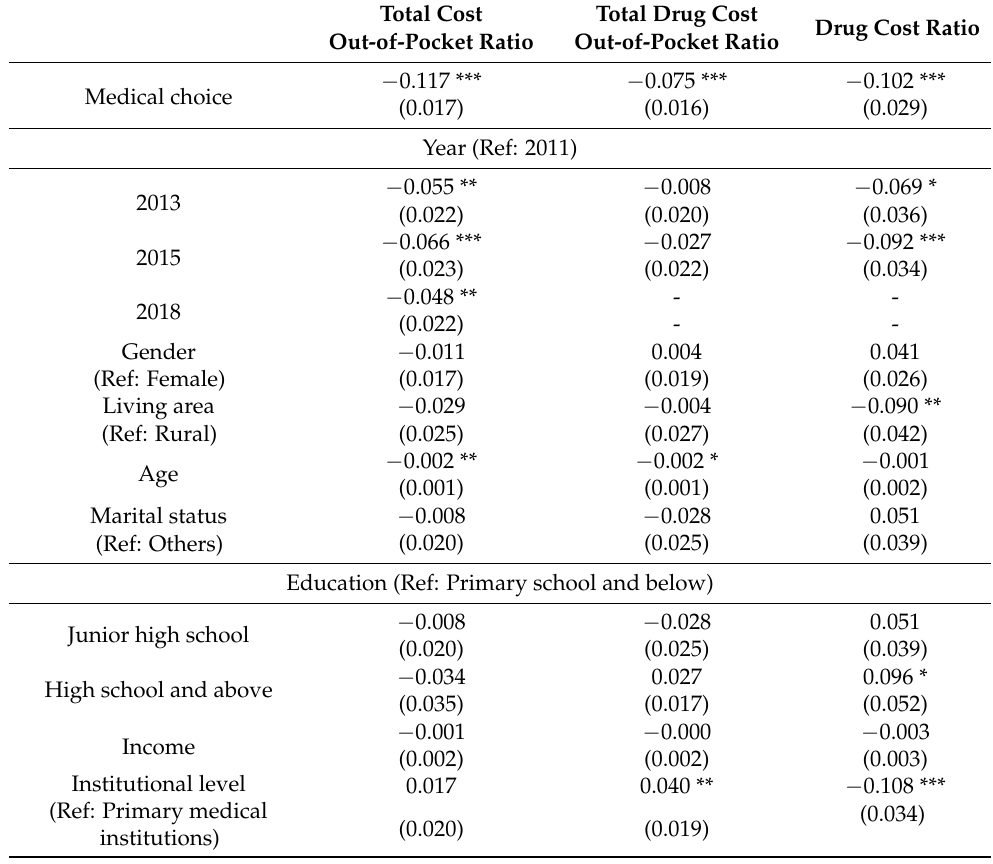
Table 5. The effect of medical choice on health costs-related